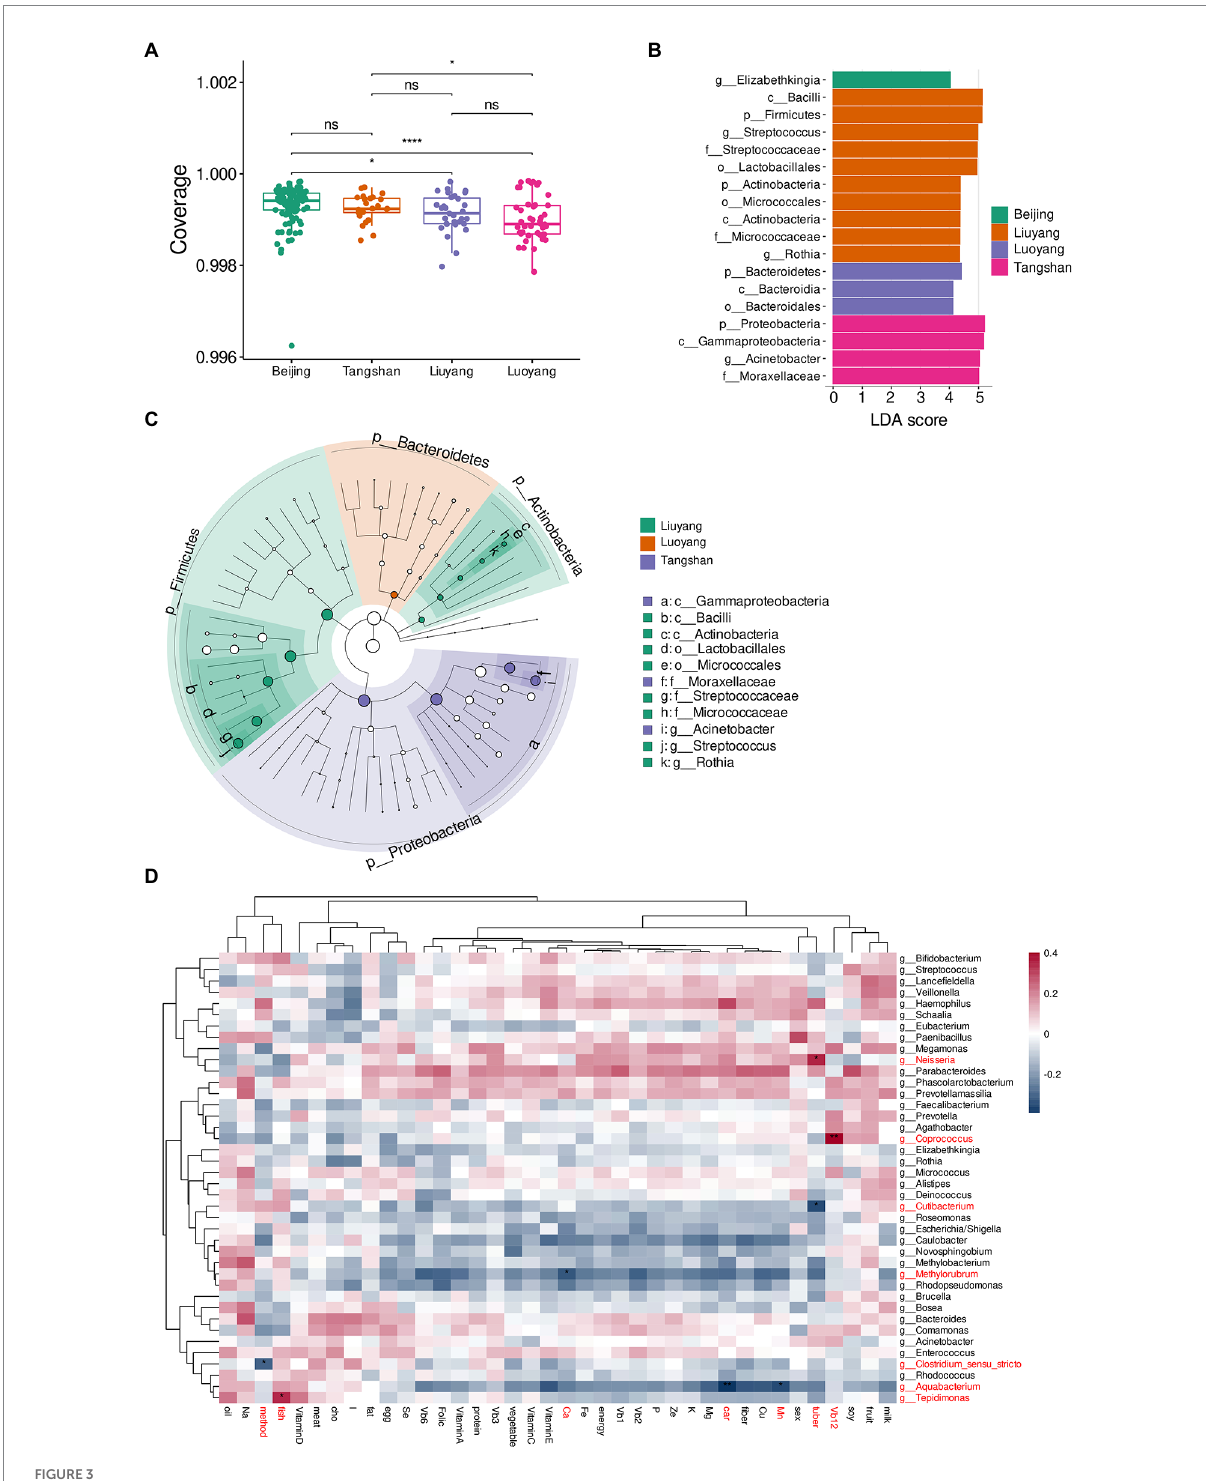
FIGURE 3 Comparison of milk microbial composition in different cities. (A) , α -diversity (observed species) based on the OTUs in Beijing (B) , Luoyang (L), Liuyang (H), and Tangshan (T). LEfSe barplot (B) and cladogram (C) of LDA value for Taxa with significant difference (LDA Score > 4, p < 0.05) between among cities. * p < 0.05; ** p < 0.01, *** p < 0.001. (D) , association heatmap of maternal diet and nutritional components with microbiome of breast milk, diet intake such as tuber, vegetable, fruit, meat, fish, egg, milk, soy, oil, and nutritional components such as energy (Kcal), protein (G), fat (g), carbohydrates (g), fiber (g), cholesterol (mg), vitamin A, vitamin B 1 , vitamin B 2 , vitamin B 6 , vitamin B 12 , folate (vitamin B 9 ), nacin (vitamin B 3 ), vitamin C, vitamin D, vitamin E, calcium (Ca), phosphorus (P), potassium (K), sodium (Na), magnesium (Mg), ion (Fe), zinc (Zn), selenium (Se), cuprum (Cu), manganese (Mn) and iodine (I). Color of cell stands for Spearman’s correlation coefficients. * p < 0.05, ** p <